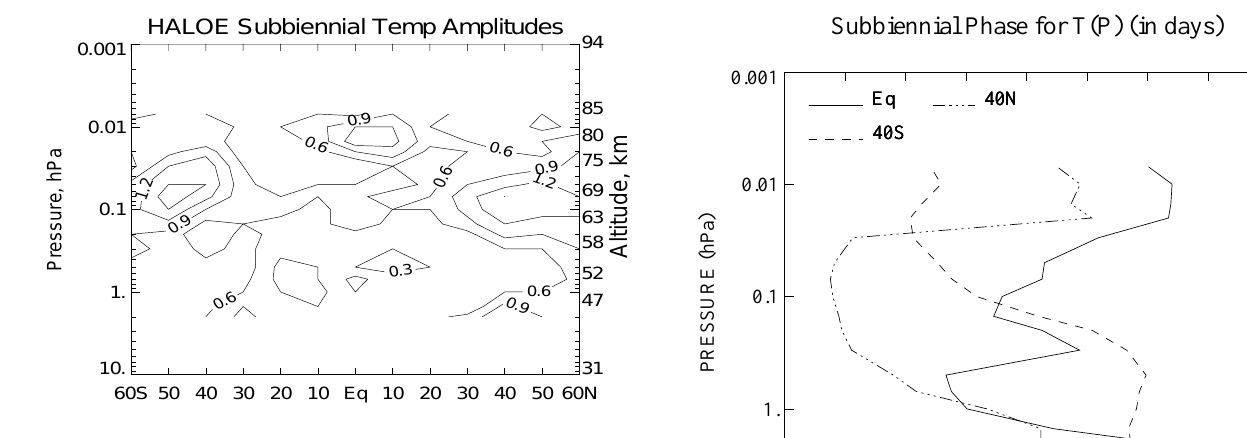
Fig. 12. Amplitudes for the subbiennial terms. Contour interval is 0.3K.